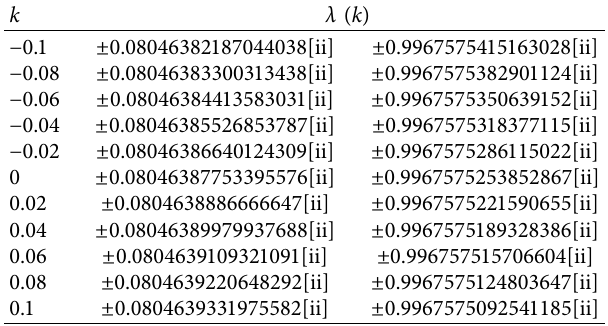
–0.1 Figure 8: Condition (48), F > 0 is satisfied for − 0 . 1 ≤ q ≤ 0 . 1 [Note: F � 1 ± O ( 10 − 8 )